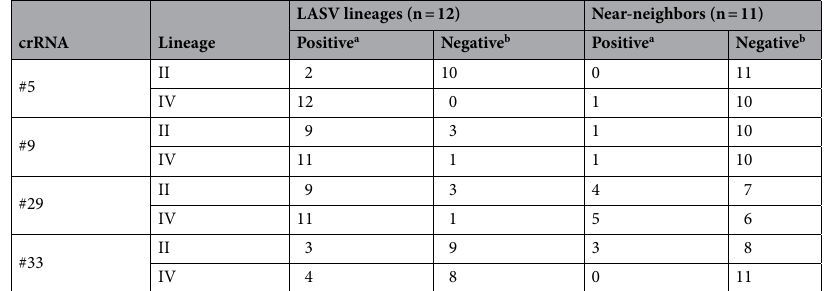
Table 2. Detection of L gene of LASV lineages and near-neighbors. a The assay was classified as positive if the integrated, background subtracted, fluorescent signal was higher than 20% of the highest signal obtained. b The assay was classified as negative if the integrated, background subtracted, fluorescent signal was equal or lower than 20% of the highest signal obtained.